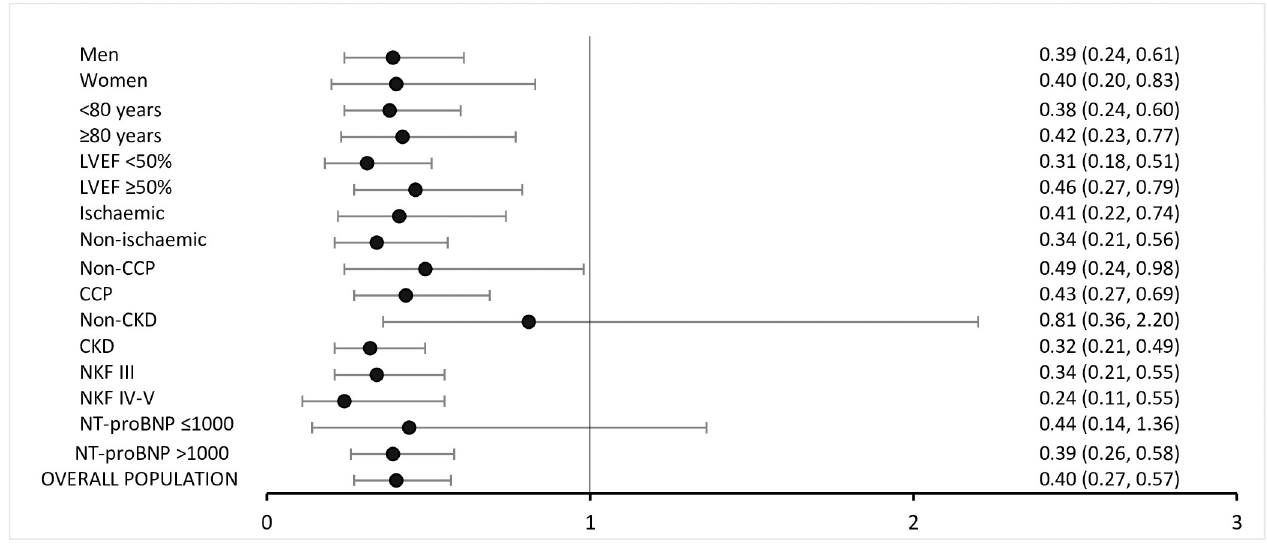
Fig 3. Multivariable binary logistic regression evaluating the outcome of HF program management vs. usual care on clinical outcomes in special subgroups.